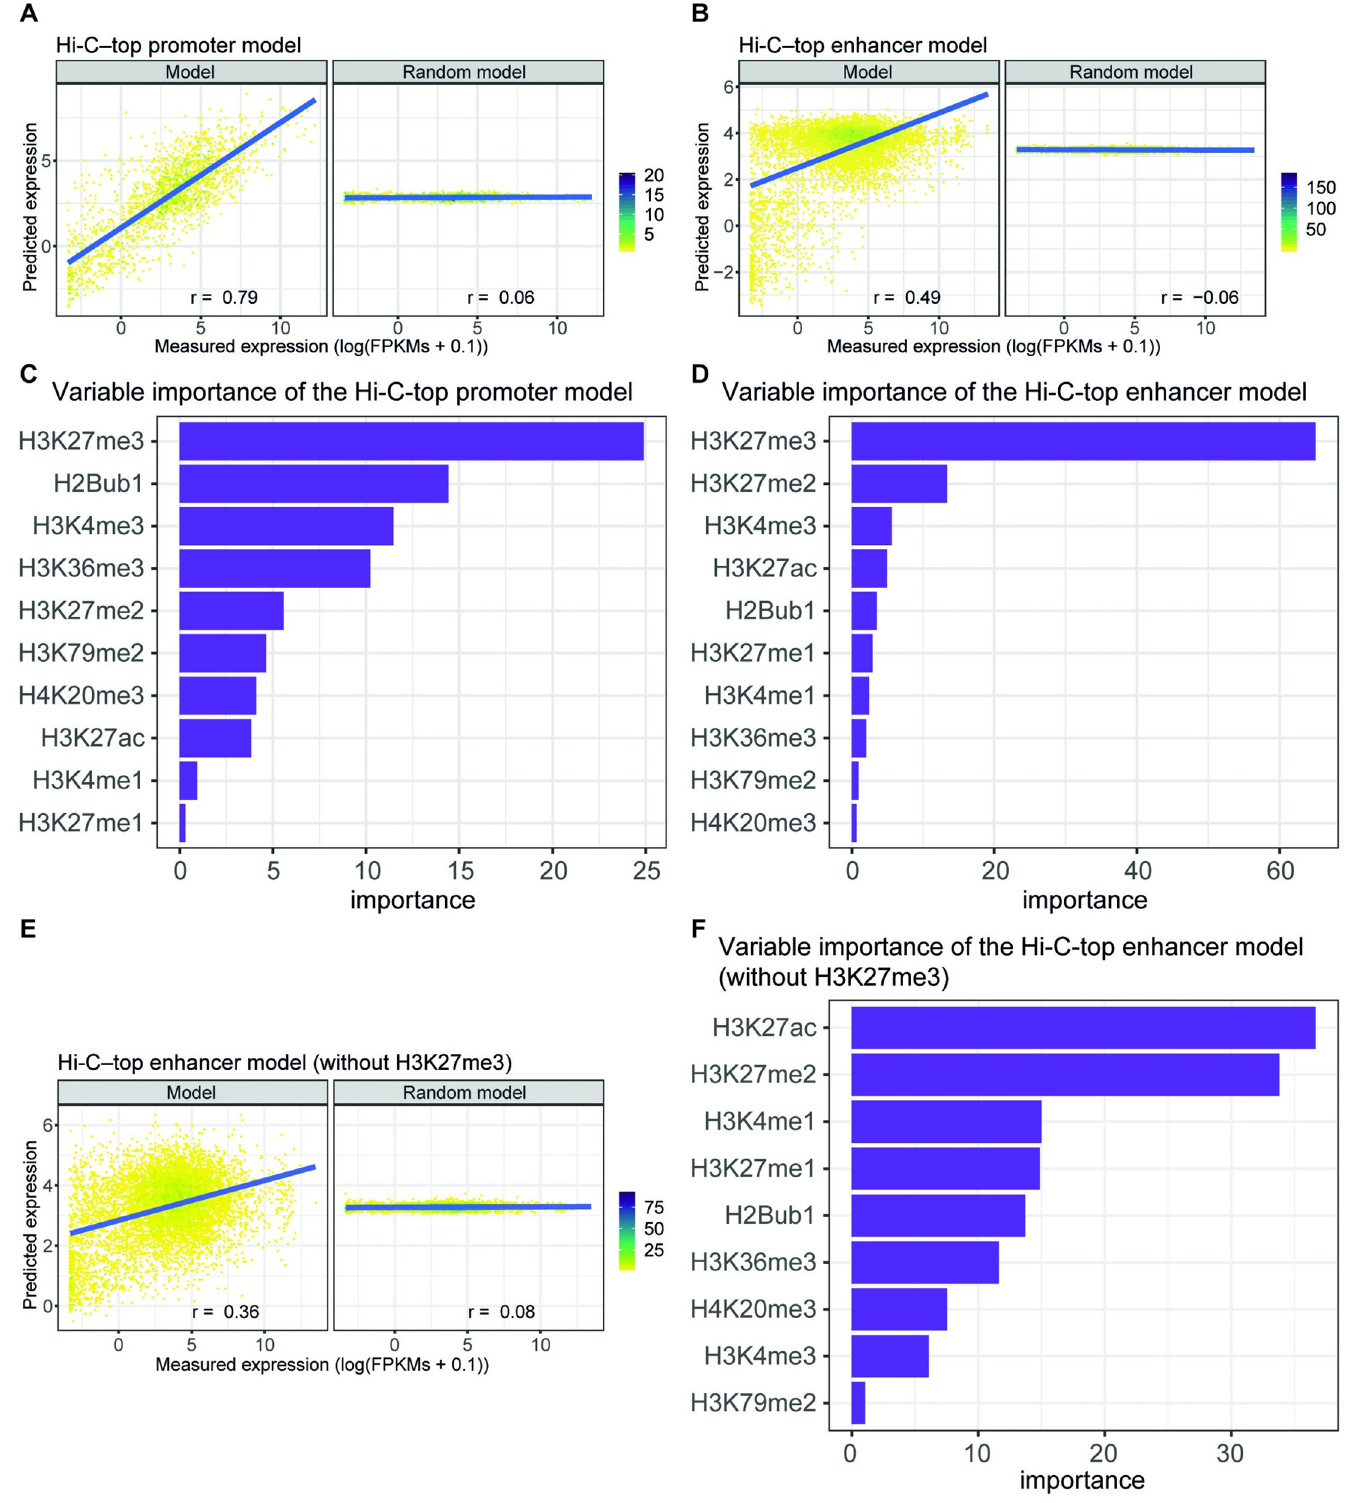
Fig 2. Performance and variable importance of enhancer and promoter Hi-C-top predictive models in ESCs. Predicted expression of the test subset of genes calculated by the models versus their measured expression by RNA-seq. Model performances are represented by the Pearson’s correlation ( r ) between predicted and measured expression values. (A) Left, the model trained on the promoter regions associated to at least one enhancer using the top significant interactions of Hi-C (Hi-